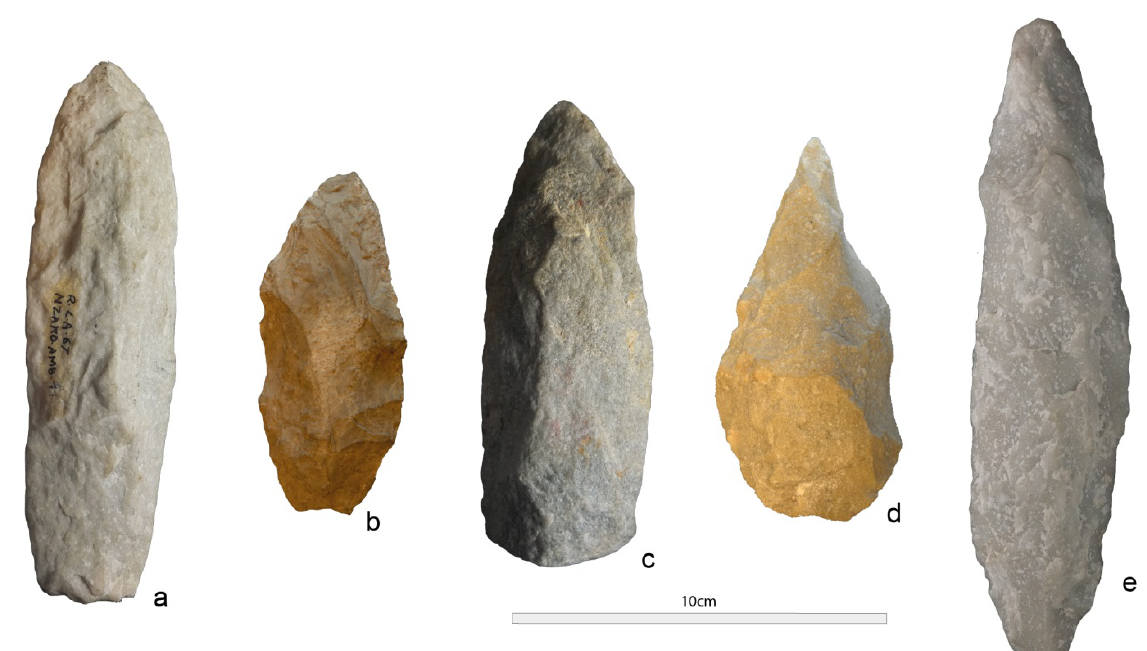
Figure 5. Examples of shaped pieces which matched the Lupemban point criteria. a, e: N’Zako Ambilo (NZA), b: M’Piaka (MP), c: N’Zako Kono (NZK), d: M’Piaka